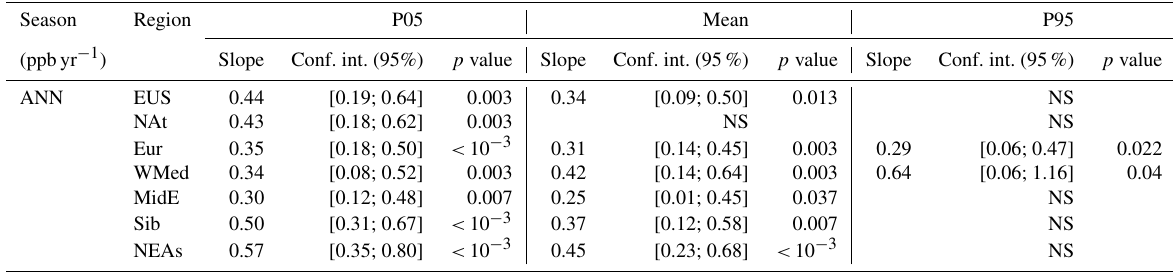
Table D1. O 3 absolute trends in ppbyr − 1 during all the year in the UT. From left to right, the anomalies are taken from deseasonalized P05, monthly means, and P95. The insignificant trends with respect to the 95% confidence level are indicated as NS.